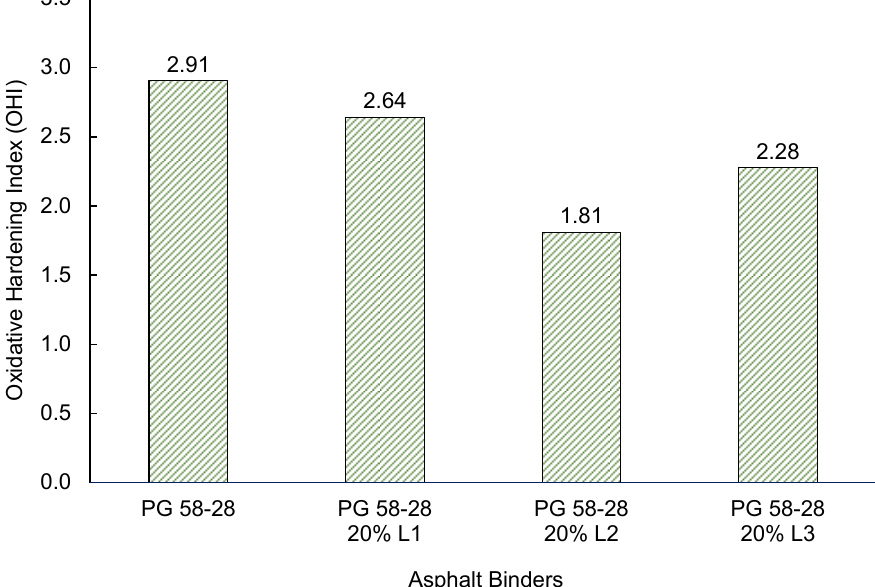
Figure 6. Oxidative Hardening Indices of Binder Blends.